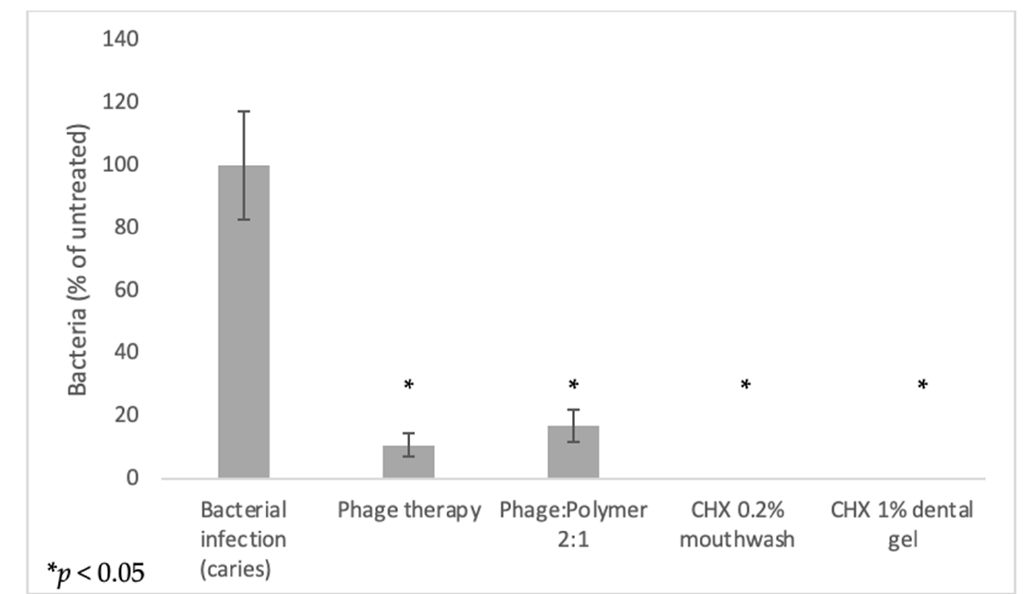
Figure 5. Viable bacterial counts decreased after treatment (% of untreated). Viable counts of SMHBZ bacteria (CFU/ mL) after treatment with phage suspension, phage:polymer formulation, chlorhexidine mouthwash 0.2%, or chlorhexidine dental gel 1% are described. Treatment with phage suspension and phage:polymer formulation reduced viable bacterial counts by more than 80%. Treatment with chlorhexidine-containing mouthwash and dental gel showed a bacteriocidic effect. Statistical significance was calculated by Student’s t -test (significance level: p < 0.05) compared to untreated control. Results are shown as mean ± SD based on five independent biological replicates.